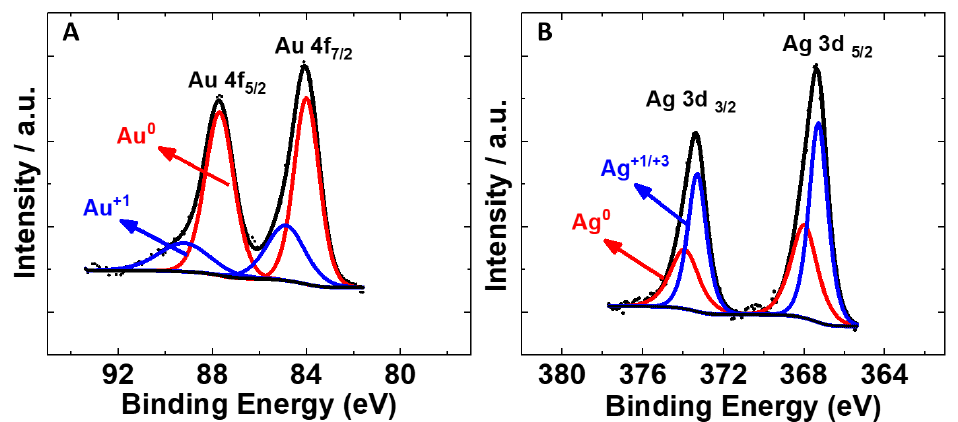
Figure 6. XPS spectra of Au ( A ) and Ag ( B ) components of nanowires produced following dilution after aging at 25 °C for 18 h.